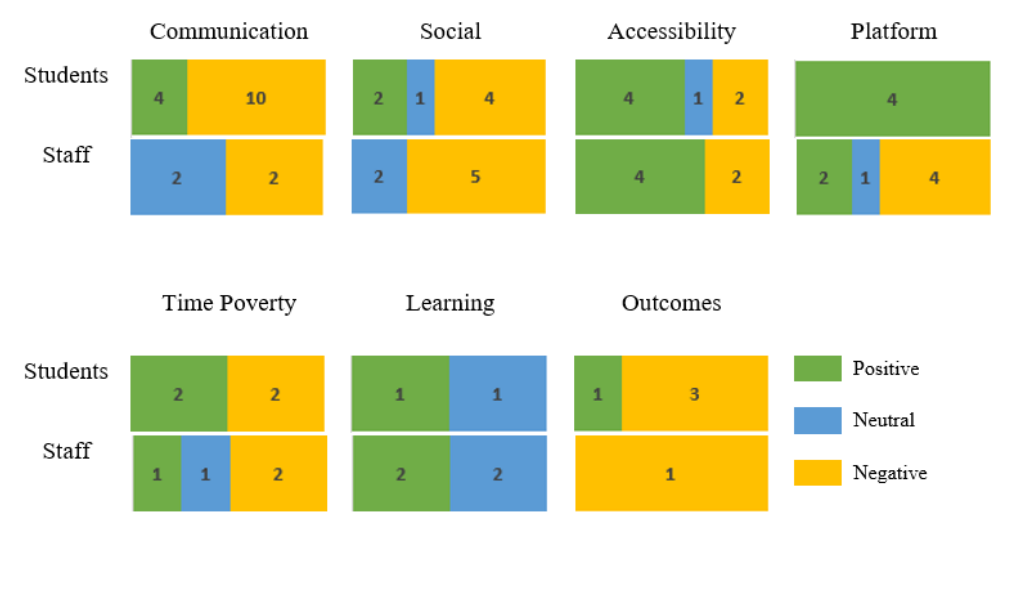
Number of Sentiment Coded Quotes by Theme and